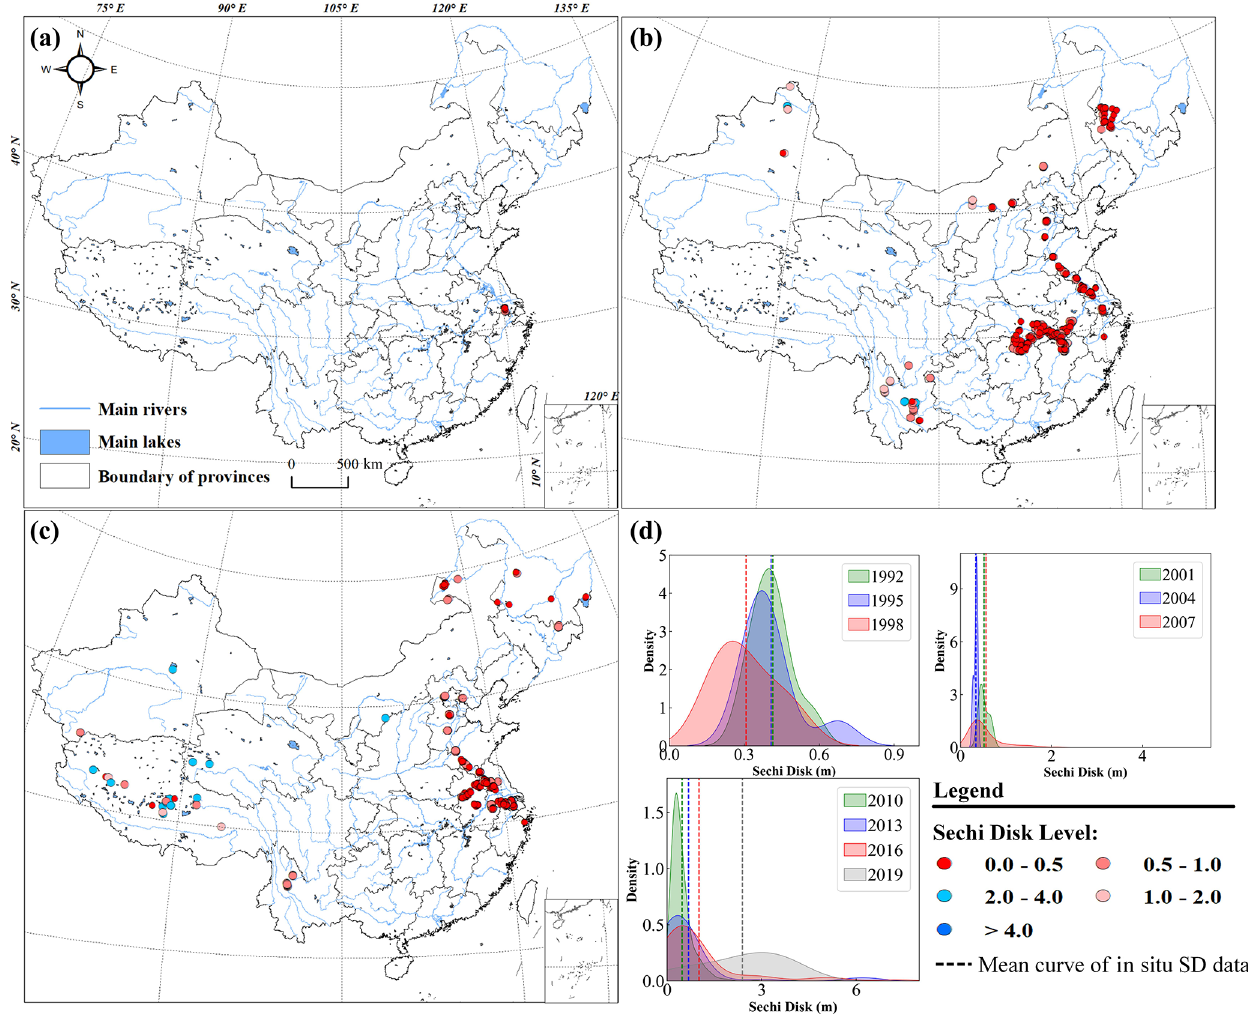
Figure 2. Details of the in situ measured SD datasets. (a–c) The geographical distributions of SD samples used to validate the accuracies of the corresponding SD products and (d) the probability density of the collected SD measurements used for each target SD product, used to show the SD range where the collected in situ SDs are mainly